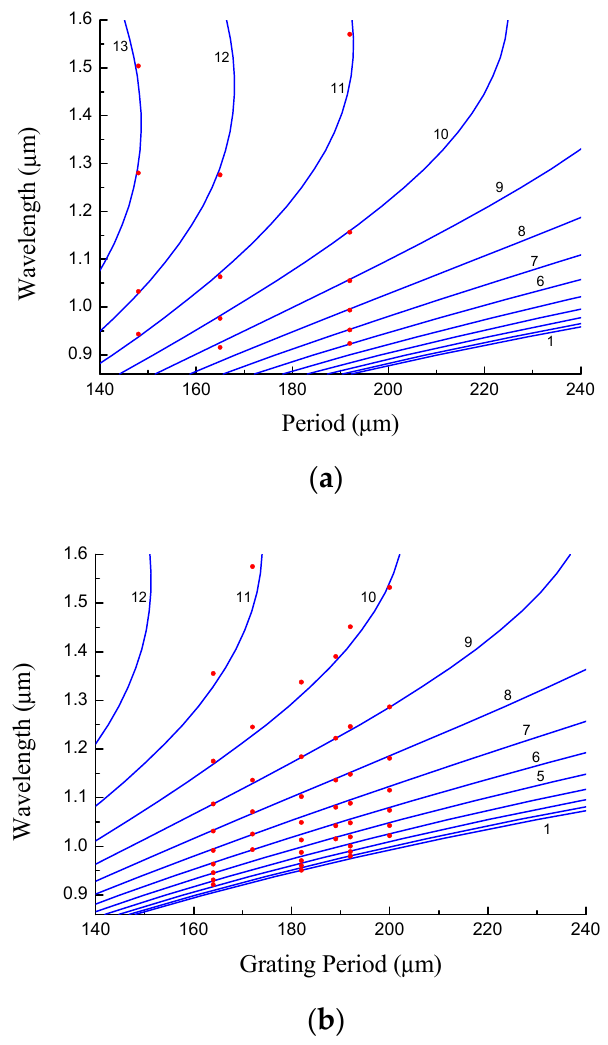
Figure 6. Resonance wavelengths of LPFGs vs. grating period for different LP 0 j cladding modes in ( a ) B/Ge#1 and ( b ) B/Ge#2 fibers.